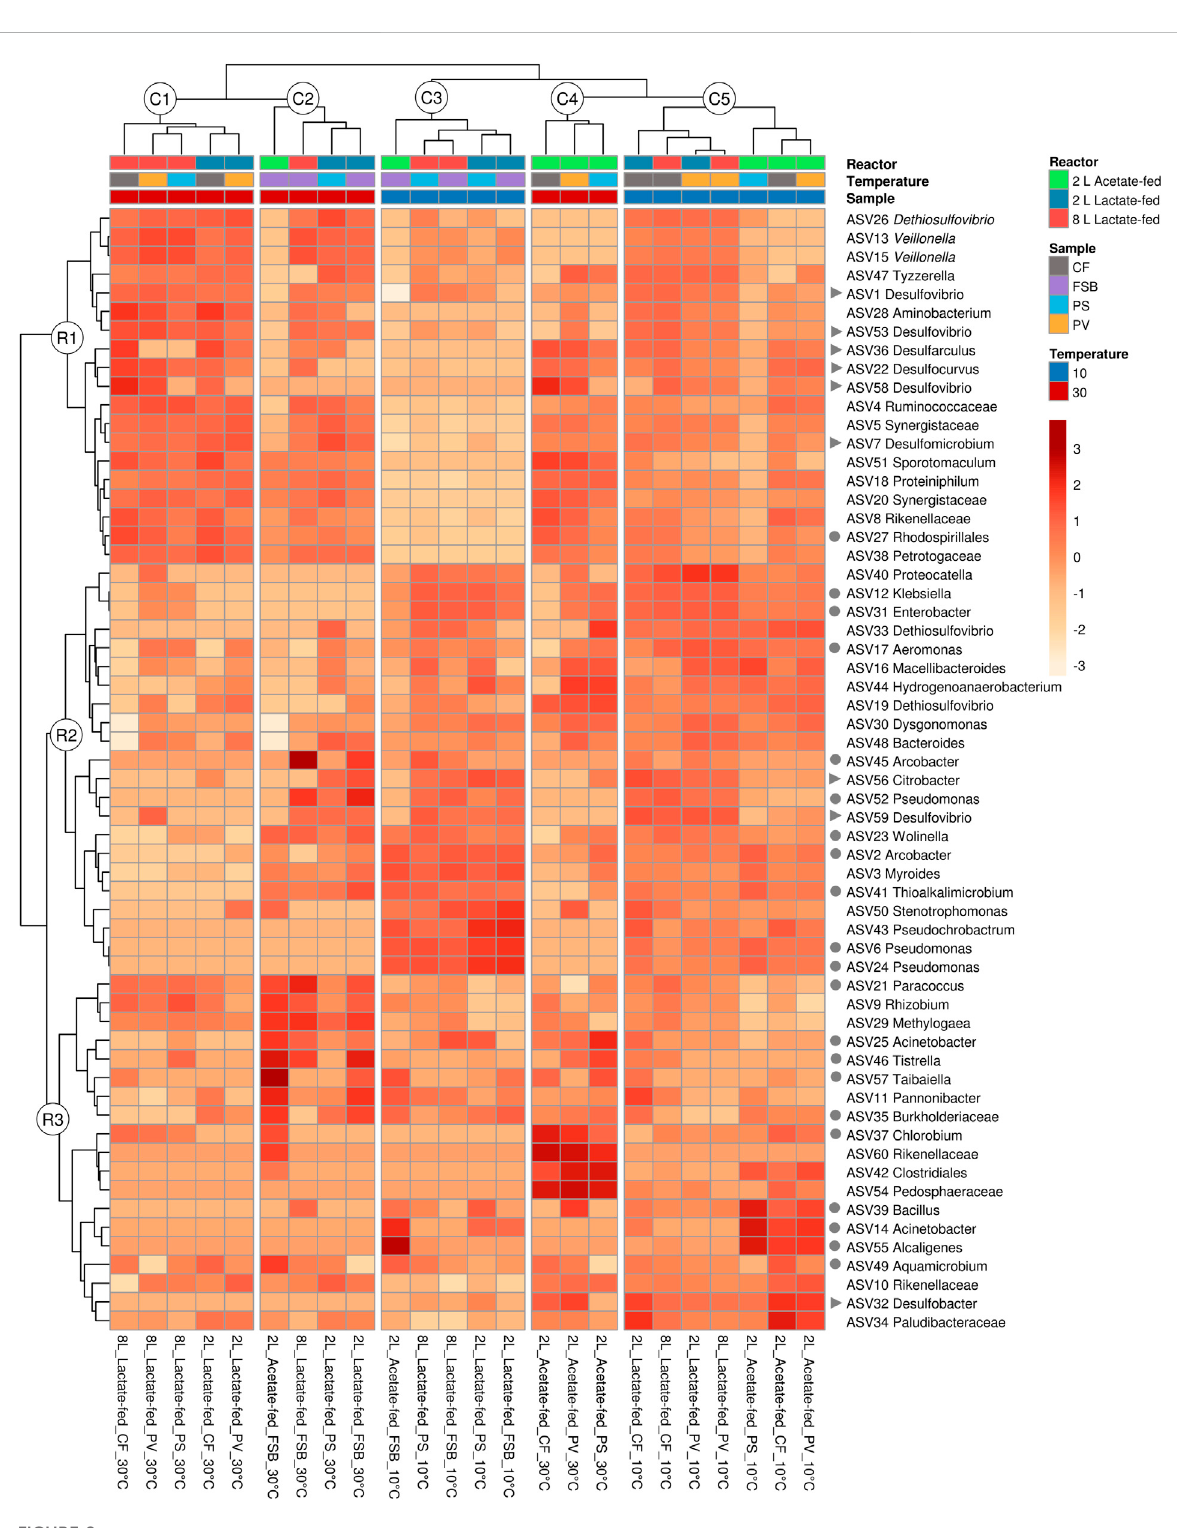
FIGURE 8 Hierarchical clustering heatmap analysis (distance measured by Euclidean and Ward linkage clustering algorithms), colour intensity re fl ects the relative abundance of identi fi ed OTUs (relative abundance ≥ 1%), showing the effect of HRT across different microbial communities (CF, PV, PS, and FSB) in the 2 L lactate-fed, 8 L lactate-fed, and 2 L acetate-fed reactors. Putative SRB ( < ) and SOB ( C ) genera are